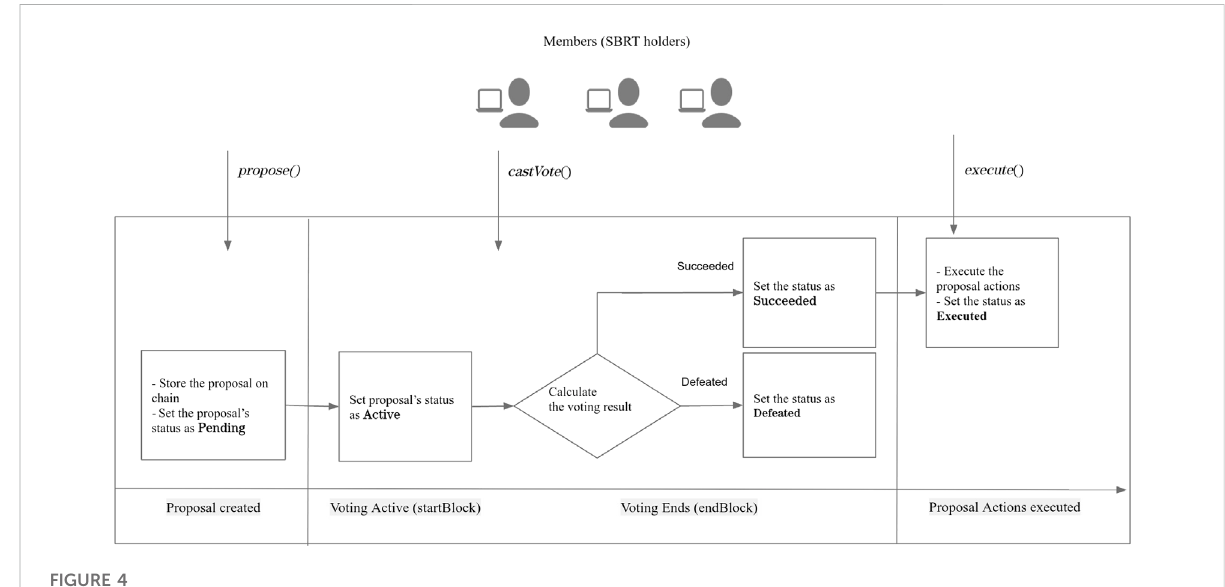
FIGURE 4 Proposal process with user actions on a